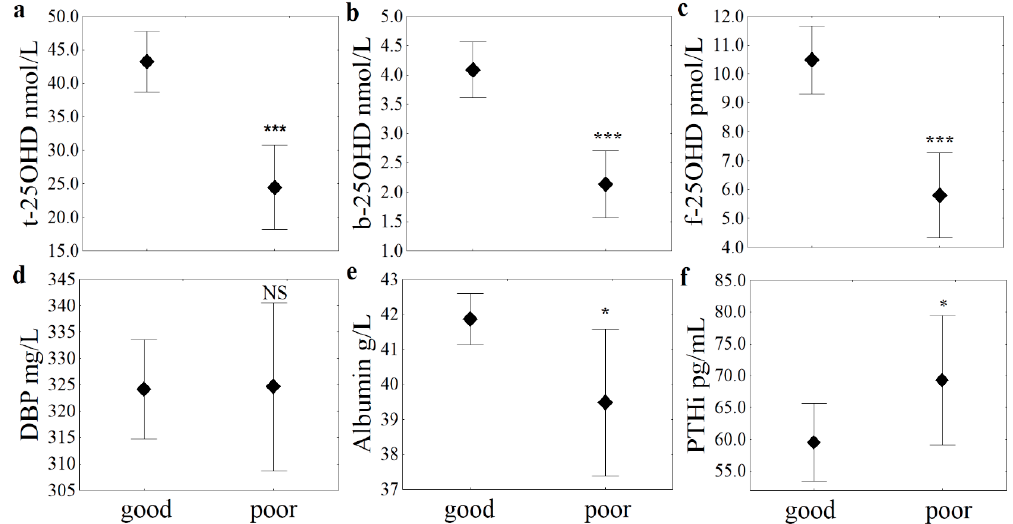
Figure 1. Levels of three 25OHD fractions and related markers in the context of post-surgery clinical condition measures. The levels of biomarkers are shown in mean ± 0.95 confidence interval.